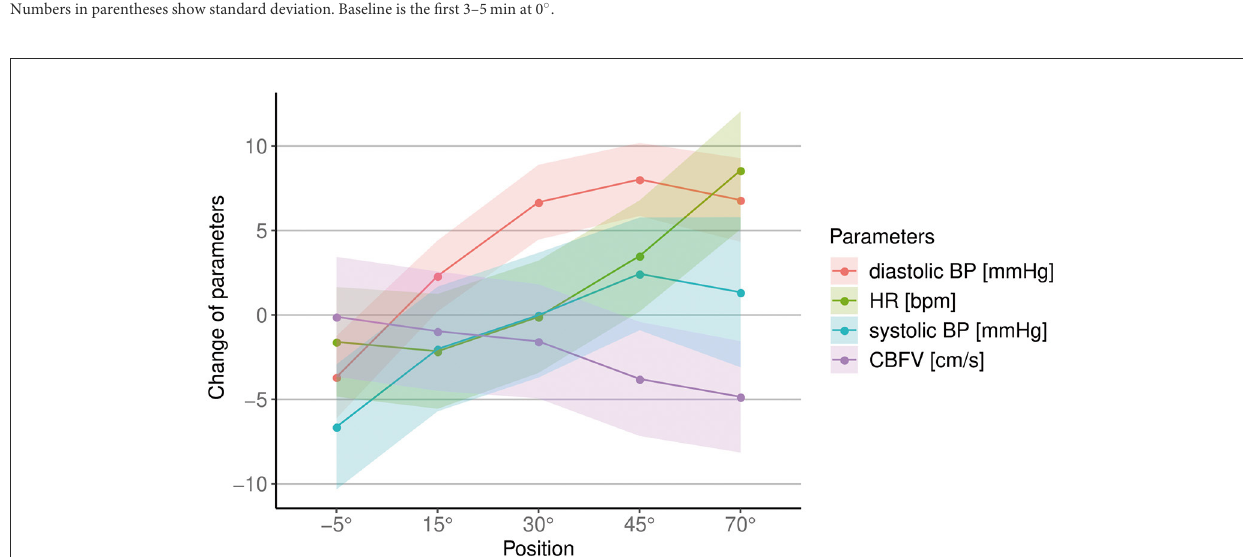
FIGURE2 Overview of changes in cerebral blood flow velocity (CBFV), systolic and diastolic blood pressure (BP) and heart rate (HR) during different body positions. The unit for each parameter is shown in the legend. Points show mean difference to baseline, shaded areas show the standard error.